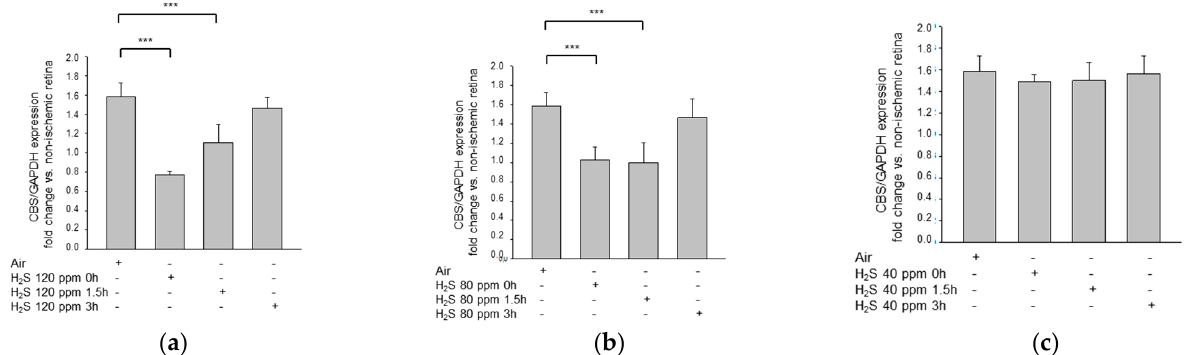
Figure 8. Effect of H 2 S inhalation on the retinal expression of CBS mRNA. Fold induction of CBS mRNA expression in ischemic retinal tissue compared to GAPDH in relation to the corresponding non-ischemic retinae analyzed by RT-PCR after ( a ) 120 ppm H 2 S inhalation (data are mean ± SD, n = 8; *** = p < 0.001, IRI vs. 120 ppm H 2 S at 0 h and vs. 120 ppm H 2 S at 1.5 h), ( b ) 80 ppm H 2 S inhalation (data are mean ± SD, n = 8; *** = p < 0.001, IRI vs. IRI + 80 ppm H 2 S at 0 h and vs. IRI + 80 ppm H 2 S at 1.5 h), and ( c ) 40 ppm H 2 S inhalation.